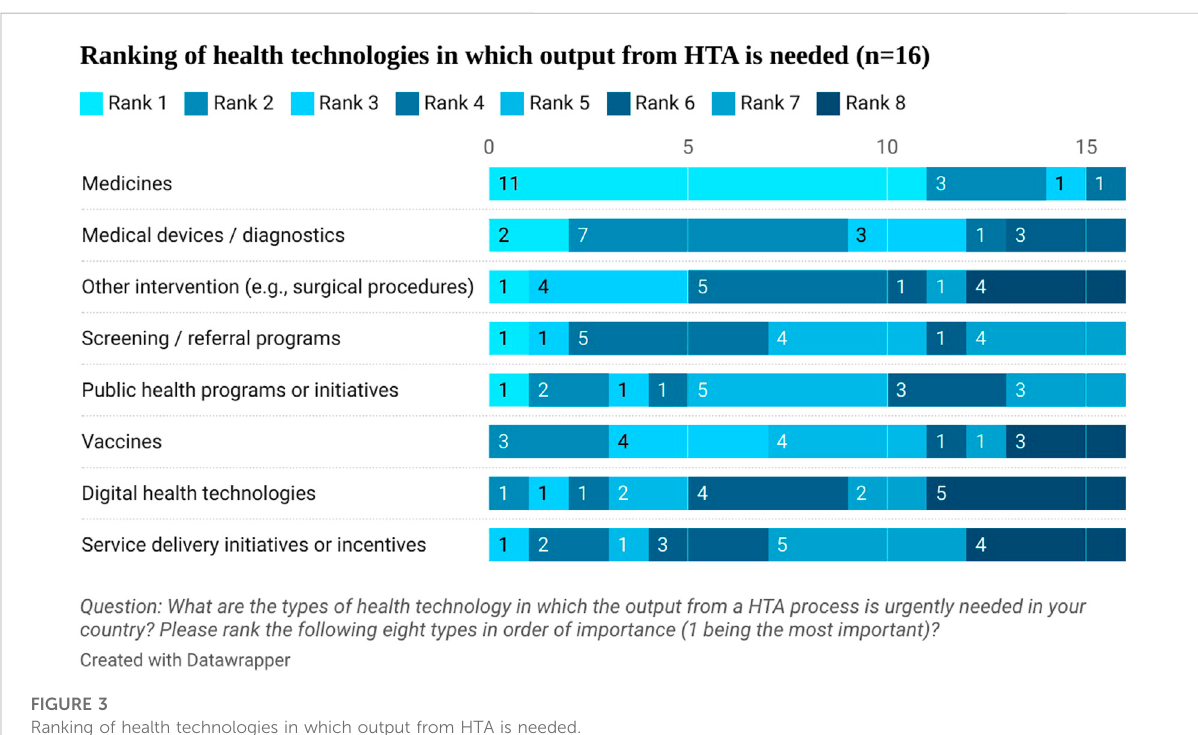
FIGURE 3 Ranking of health technologies in which output from HTA is needed.